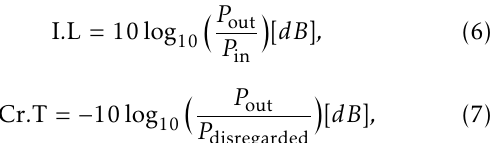
Figure 6. Electric field patterns for TE (d-f) to three different outputs, Contour maps of electric field distributions at input modes (g) TE bars indicate the normalized field intensity.